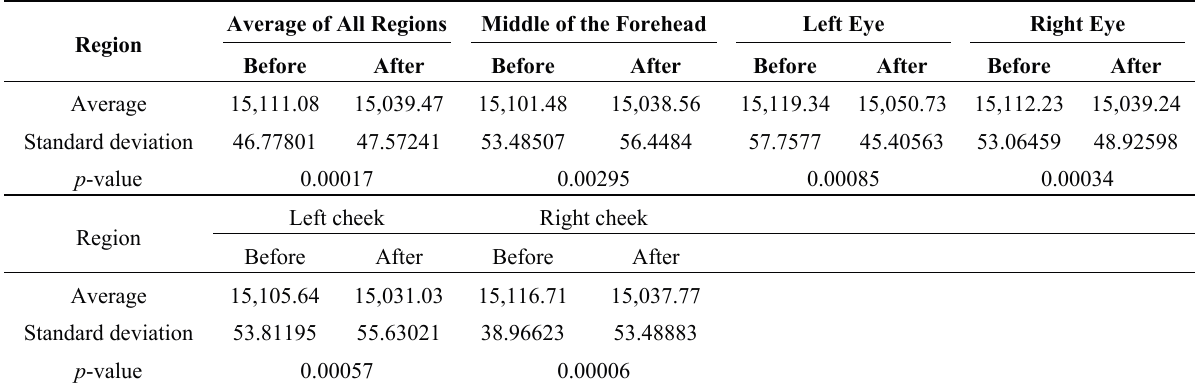
Table 5. Average, standard deviation and p -value of the facial temperature for each facial feature region.